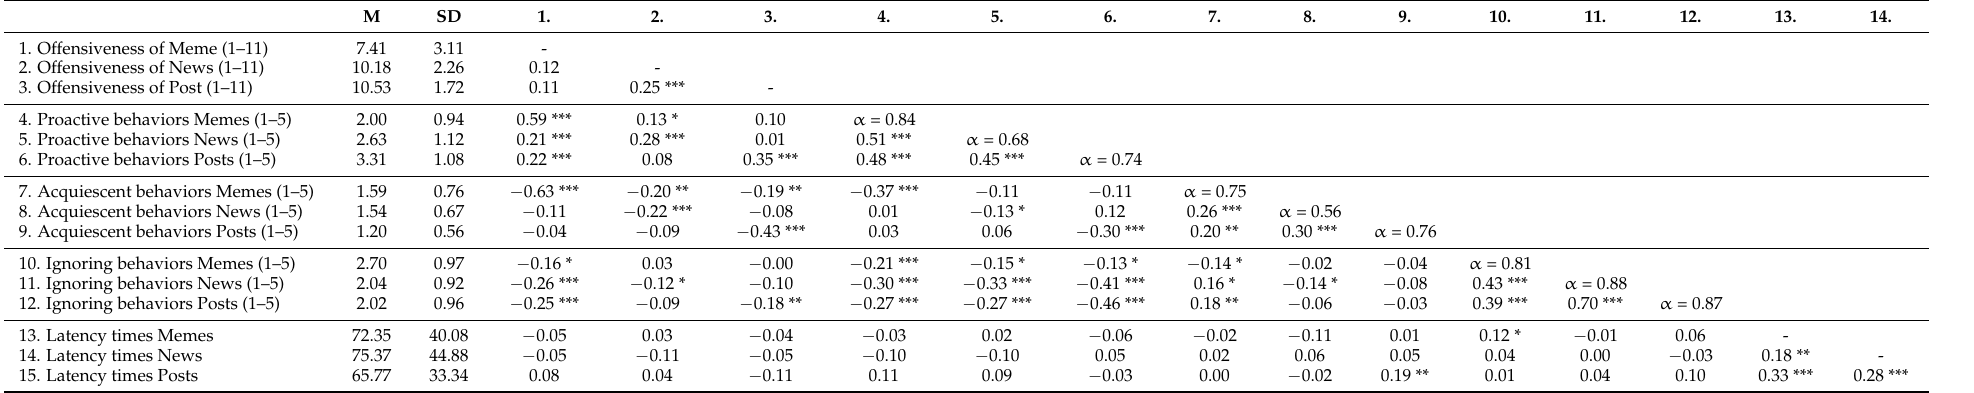
Table 1. Means, standard deviations, and Pearson’s correlations among considered